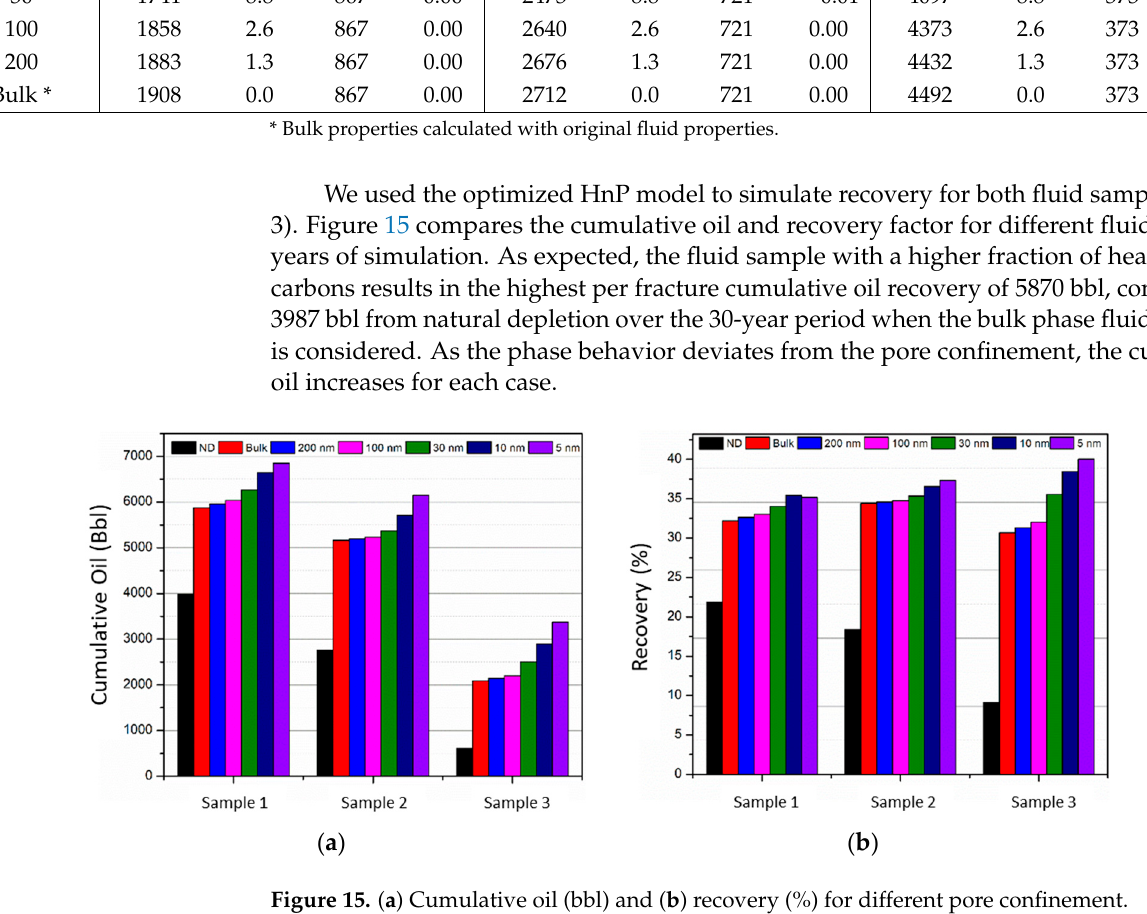
Figure 14. Minimum miscibility pressure change for Sample 2 and Sample 3 fluid with respect to pore radius.